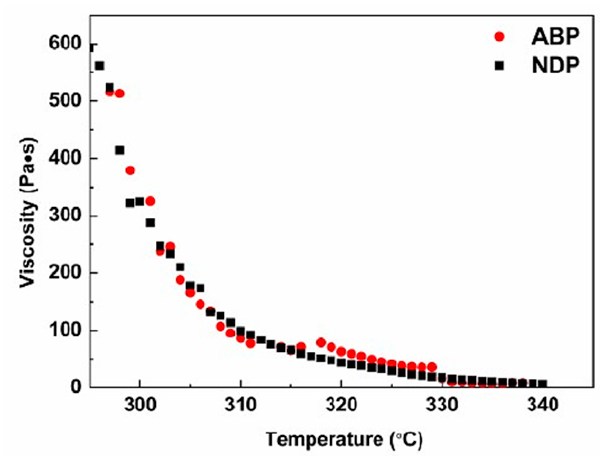
Figure 5. Viscosity–temperature curves of the NDP and the ABP.